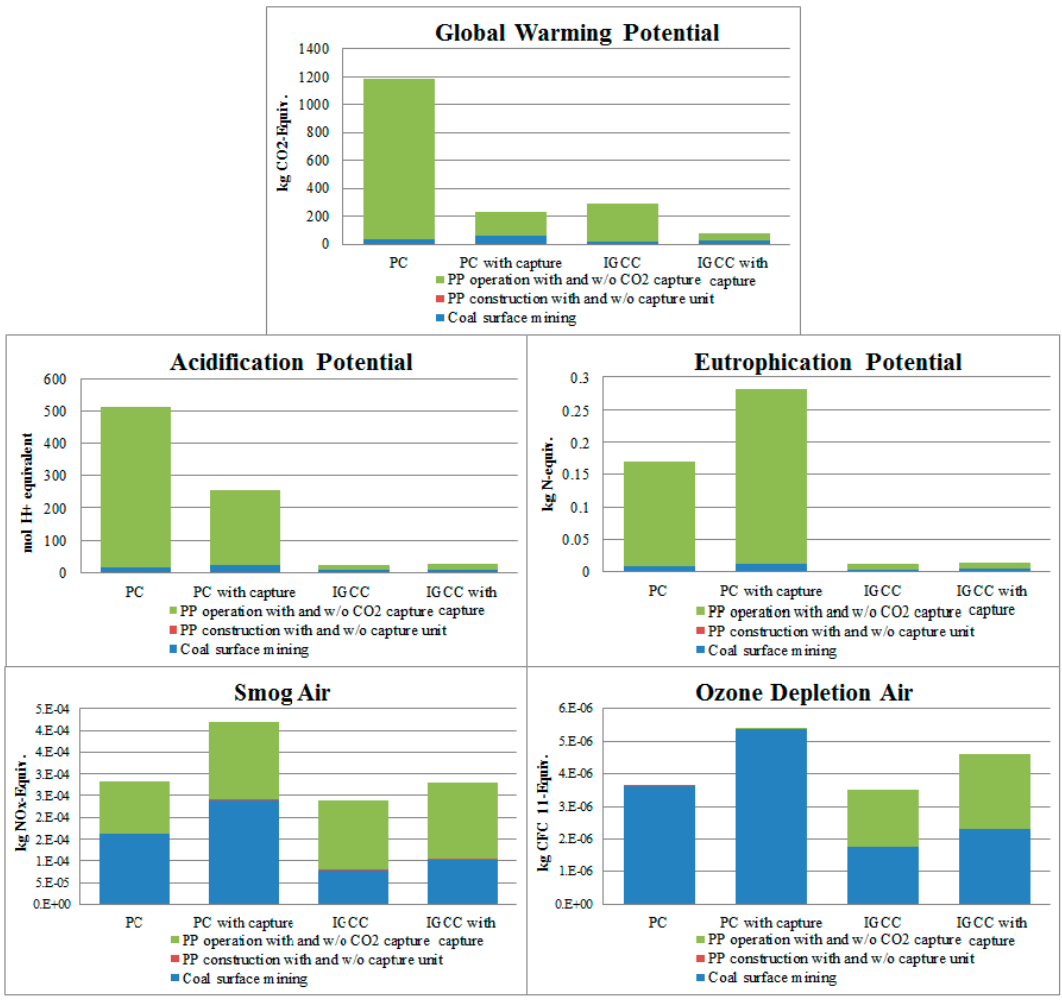
Figure 8. Life-cycle impact assessment.